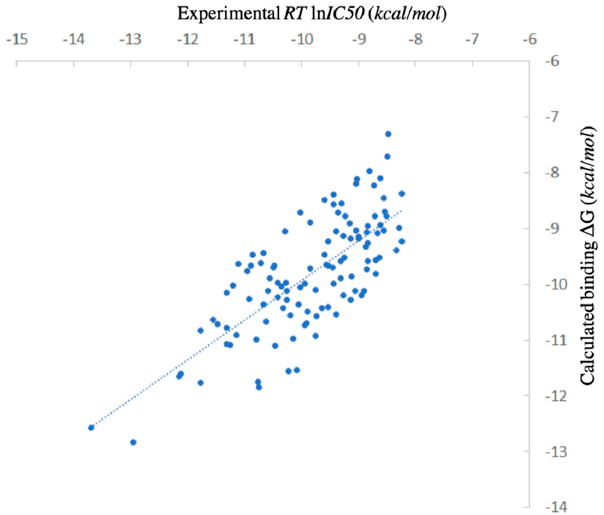
Figure 1. Scattered plot comparing binding free energy calculated by Movable Type Method to experimental data for the DUD-E CASP3 test set (Table experimental data for the DUD-E CASP3 test set (Table S1).